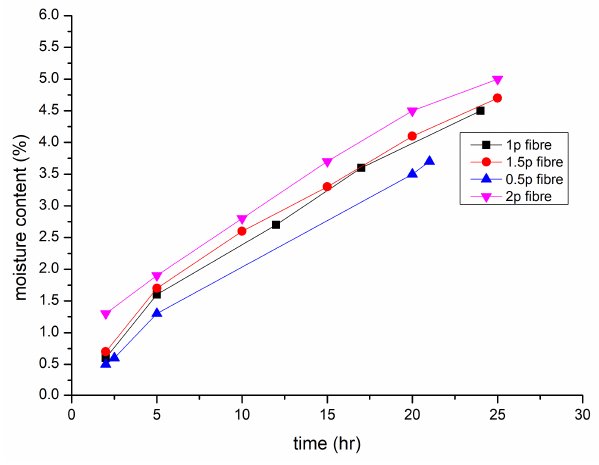
Figure 14. Moisture Content [10].